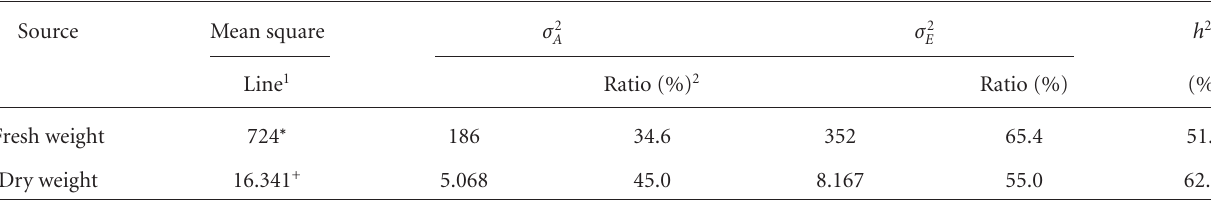
Table 1. Mean square, estimated ratio for additive and error variance, and narrow sense heritability on trionelline biosynthesis among 70 recombinant inbred lines derived from a cross between Essex and Forrest. Source Mean square σ 2 A